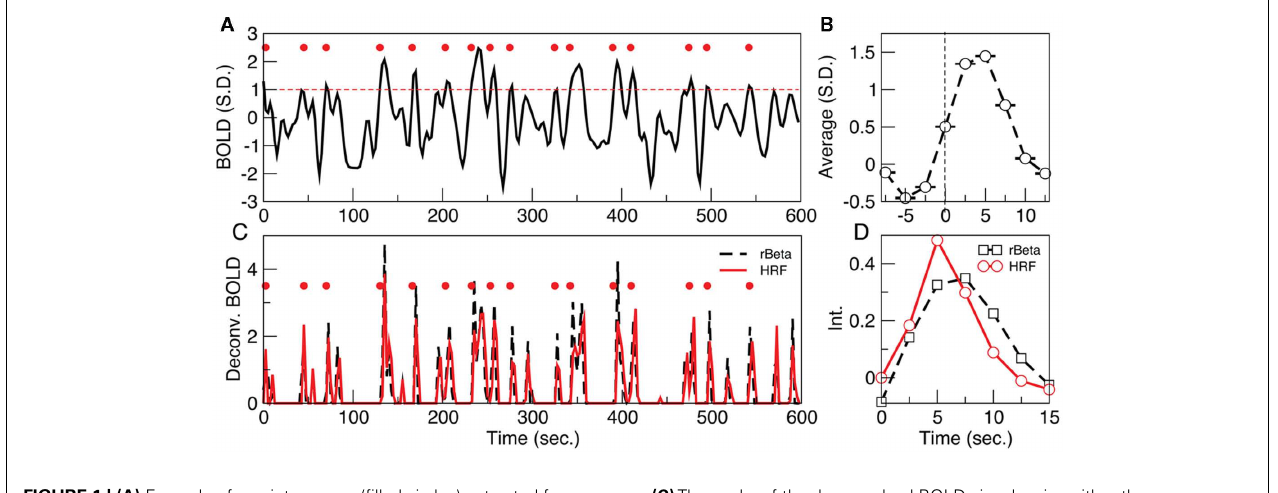
FIGURE 1 | (A) Example of a point process (filled circles) extracted from the normalized BOLD signal. Each point corresponds to a threshold (dashed line at 1SD) crossing from below. (B) Average BOLD signal (from all voxels of one subject) triggered at each threshold crossing.